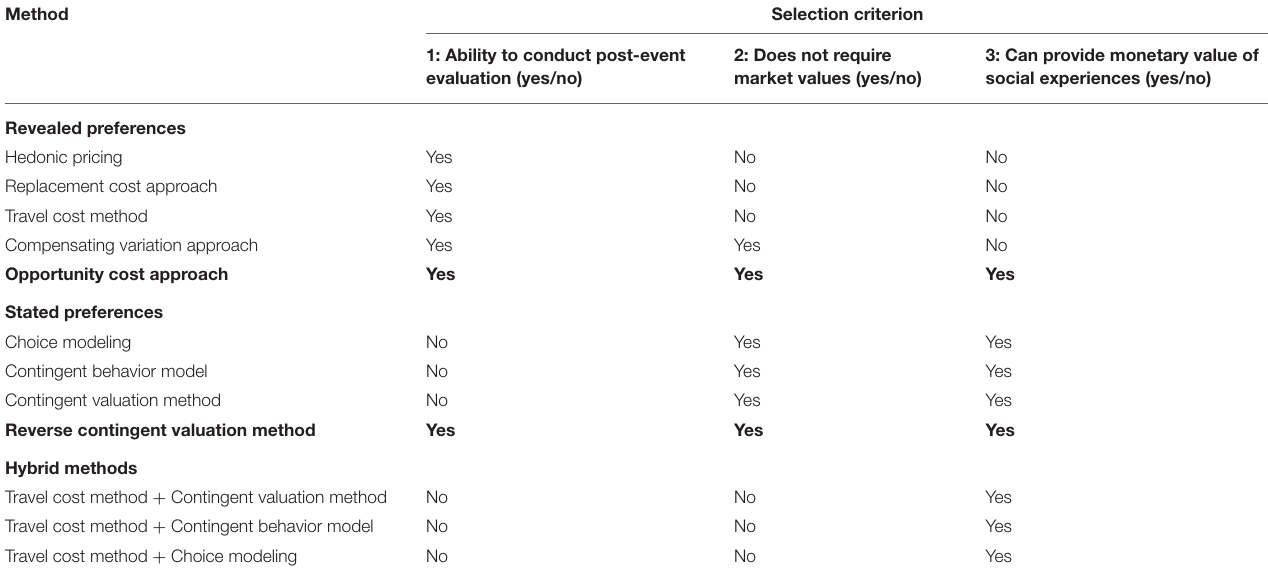
TABLE 1 | Review of monetary valuation methods.